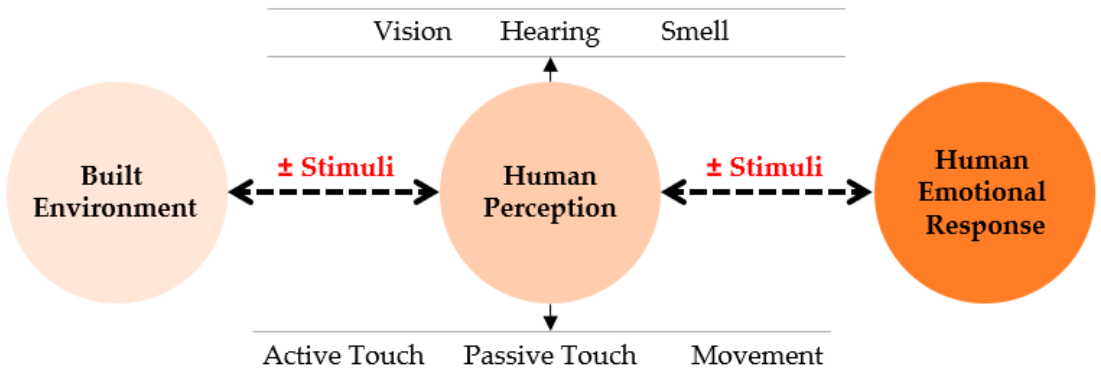
Figure 8. Relationship between the built environment and human responses. Modified from Source: [2–6,39,40,42–44].